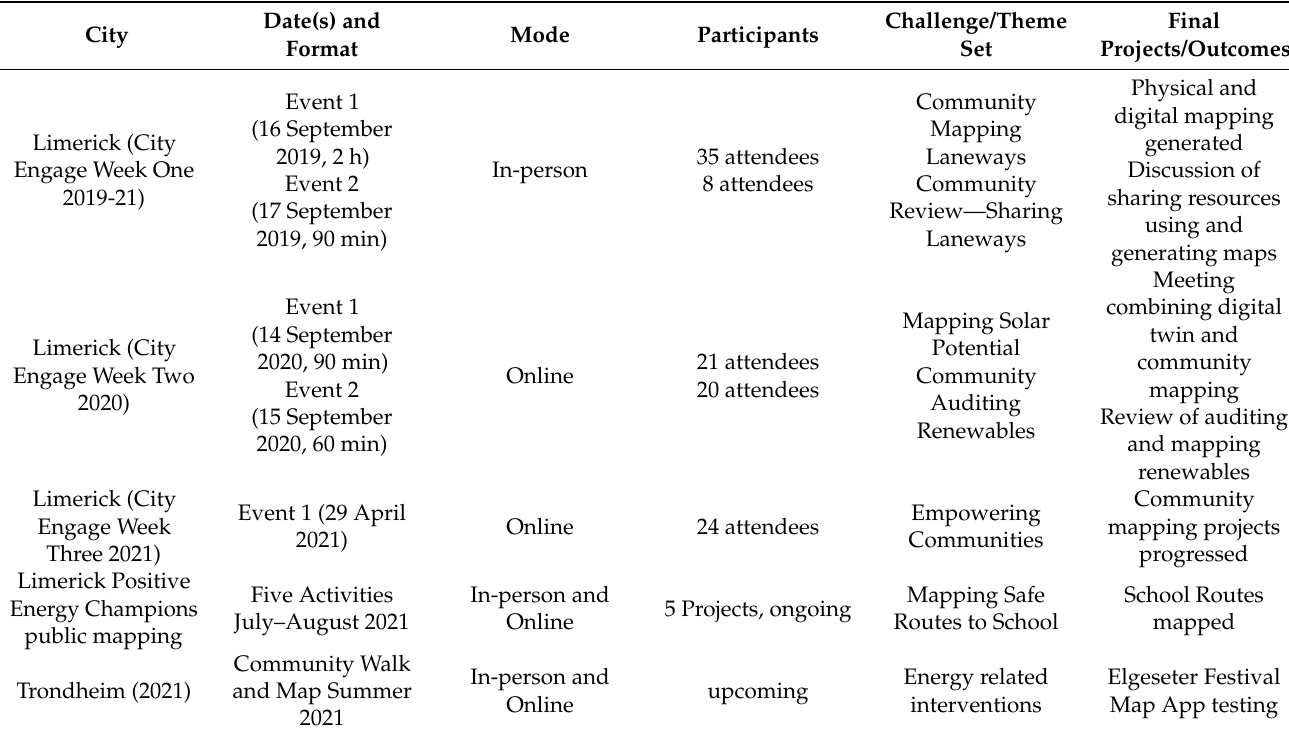
Table 4. Overview of +CityxChange Mapping Events (2019 to mid-2021).